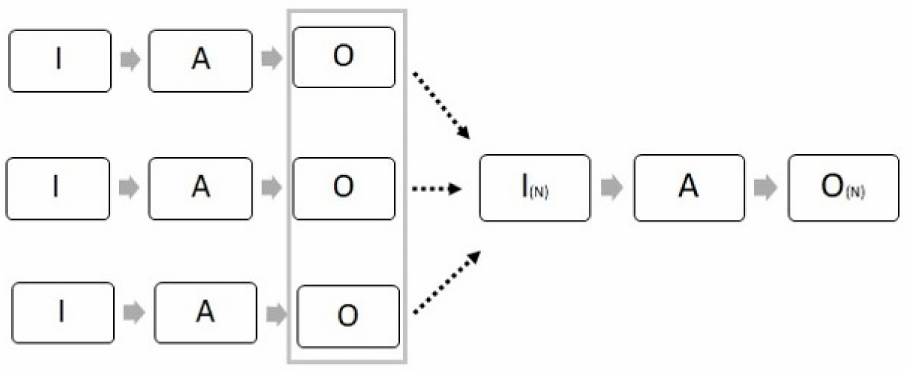
Figure 4. Process evolution type